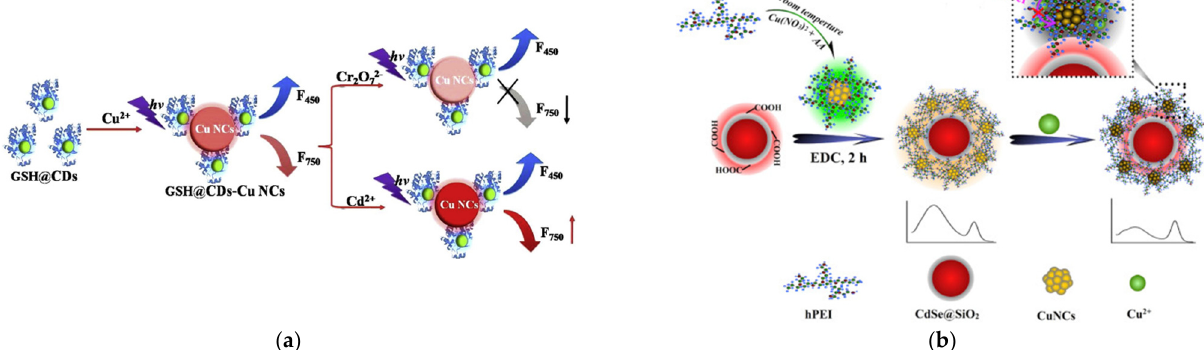
Figure 5. ( a ) Schematic illustration of the preparation of GSH@CDs-Cu NCs and the application in the detection of Cr 2 O 72 − and Cd 2+ ions; ( b ) Schematic illustration of the preparation of dual-emission ratiometric fluorescence probe and its sensing mechanism to Cu 2+ ions. Table 2. List of fluorescent probes based on Cu NCs for heavy metal detection.